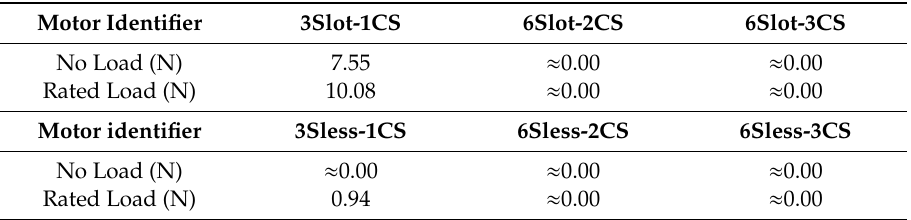
Table 3. Radial force of six analyzed motors under an ideal